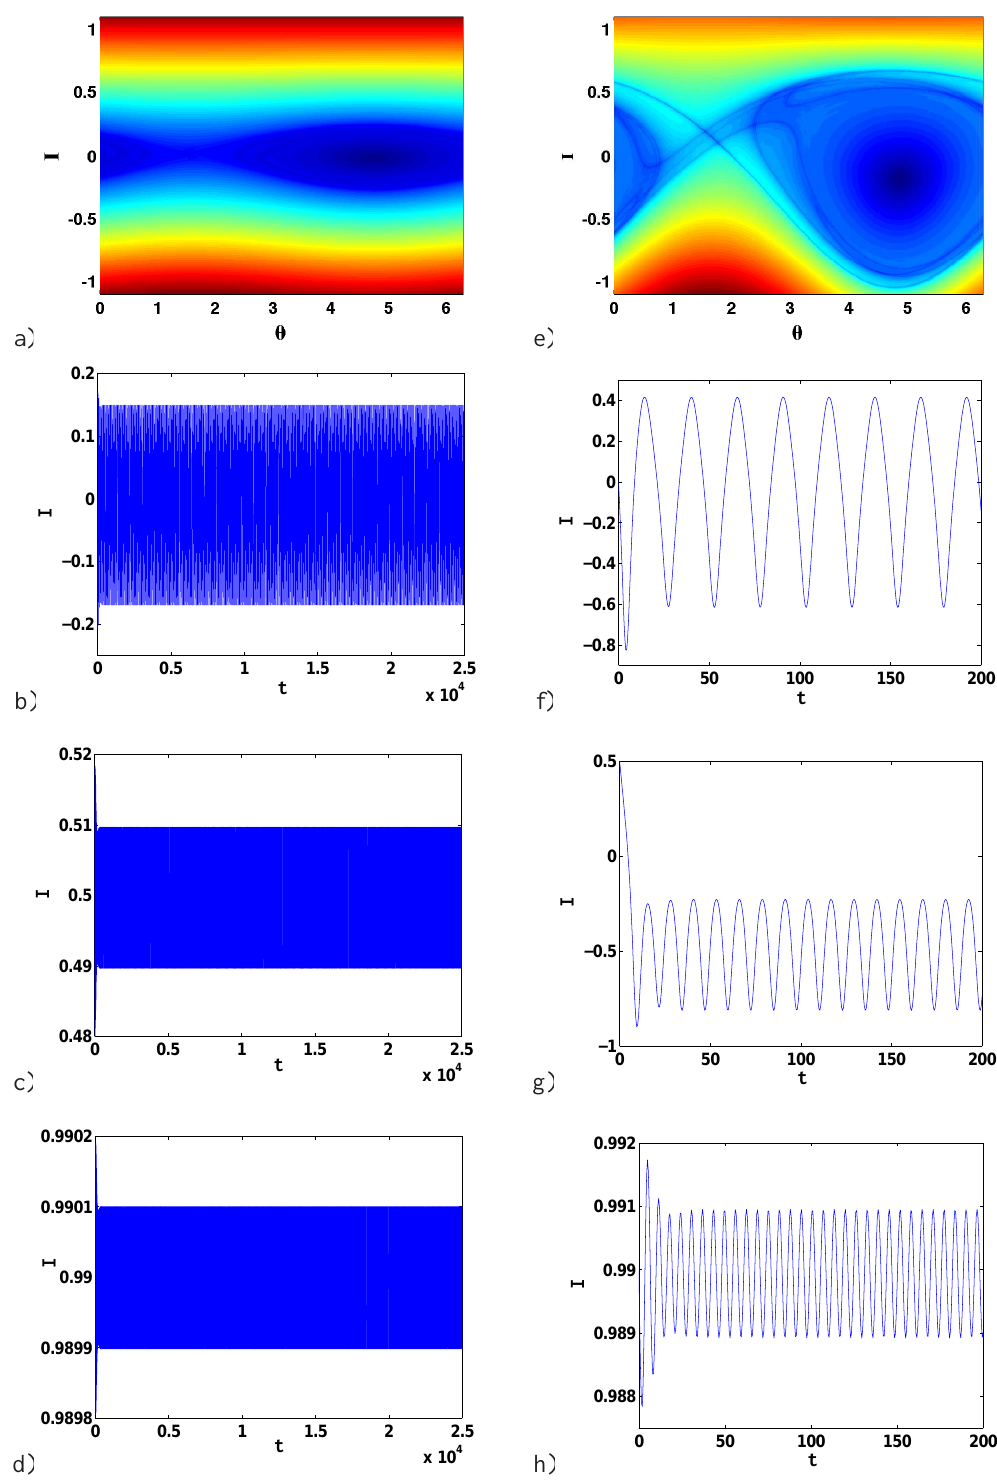
Fig. 4. Results obtained for the time dependence given by Eq. (36). The first column is for ε = 0 . 01, √ ε = 0 . 1 . a) Lagrangian descriptor evaluated in the domain [ 0 , 2 π ]×[− 1 . 1 , 1 . 1 ] at t = 0 for τ = 160; (b) , (c) , and (d) show the I component of the trajectory as a function of time for the following initial conditions: (b) θ = 0 ,I = 0; (c) θ = 0 ,I = 0 . 5; (d) θ = 0 ,I = 0 . 99. The second column is for ε = 0 . 1, √ ε = 0 . 31623. (e) Lagrangian descriptor evaluated in the domain [ 0 , 2 π ]×[− 1 . 1 , 1 . 1 ] at t = 0 for τ = 160; (f) , (g) , and (h) show the I component of the trajectory as a function of time for the following initial conditions: (f) θ = 0 ,I = 0; (g) θ = 0 ,I = 0 . 5; (h) θ = 0 ,I = 0 .